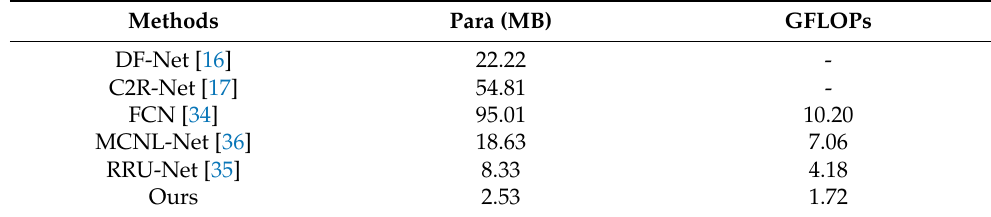
Table 5. Complexity of different